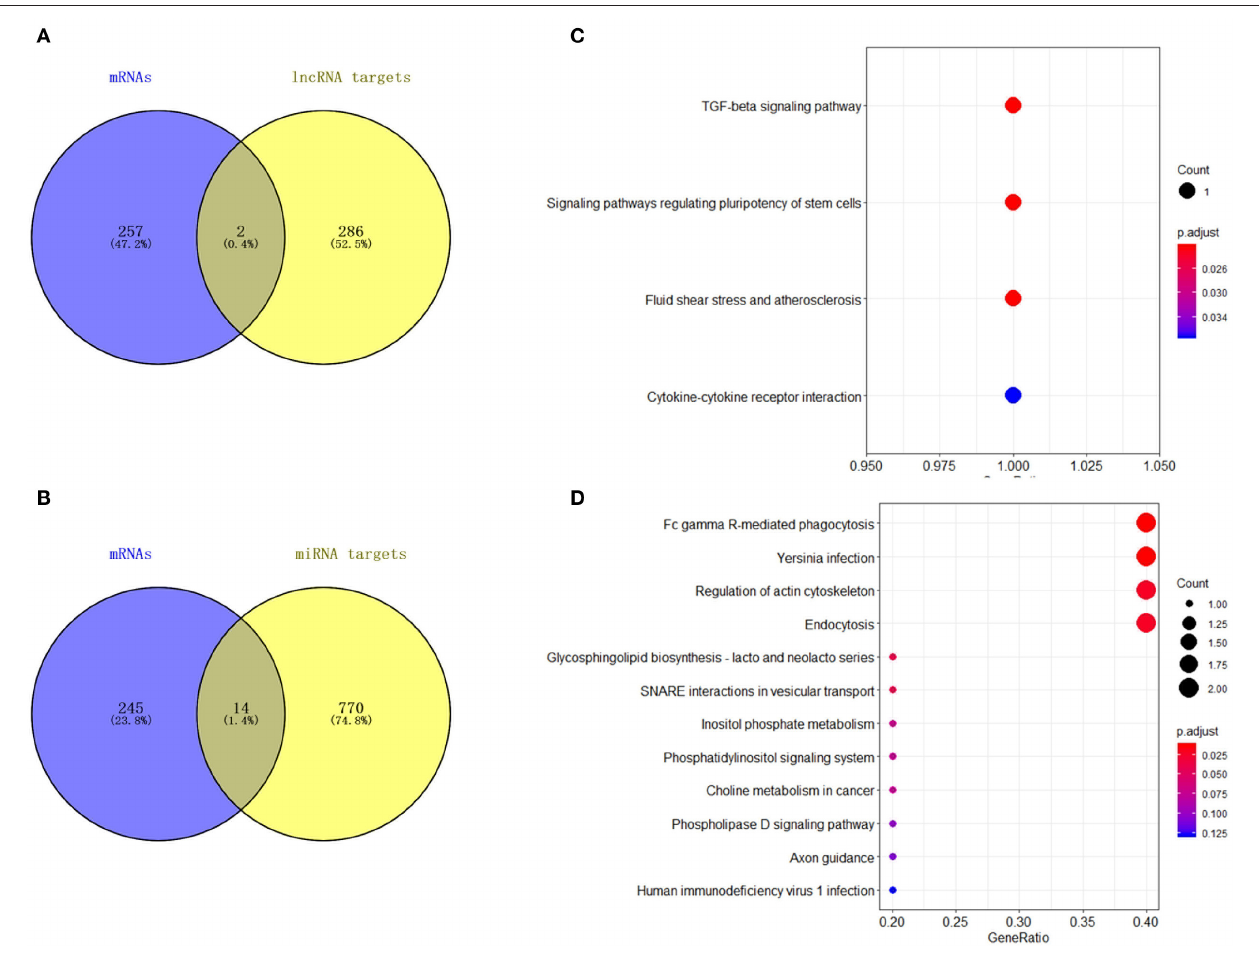
FIGURE 8 | Analysis of DElncRNA target genes and DEmiRNA target genes. (A) Venn map analysis of DElncRNA target genes and DEmRNAs . (B) Venn map analysis of DEmiRNA target genes and DEmRNAs. (C) KEGG pathway classification for the annotation of two common target genes from the DEmRNAs and DElncRNA target genes in mammary epithelial cells. (D) KEGG pathway classification for the annotation of 14 common target genes from the DEmRNAs and DEmiRNA target genes in mammary epithelial